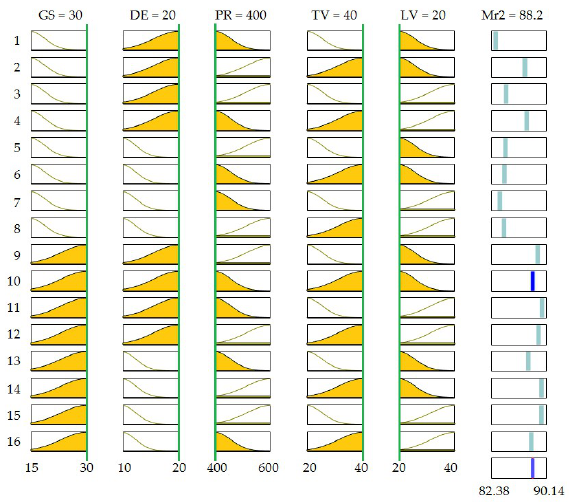
Figure 5. Output of the ANFIS model for experiment #10, in the case of Mr2.